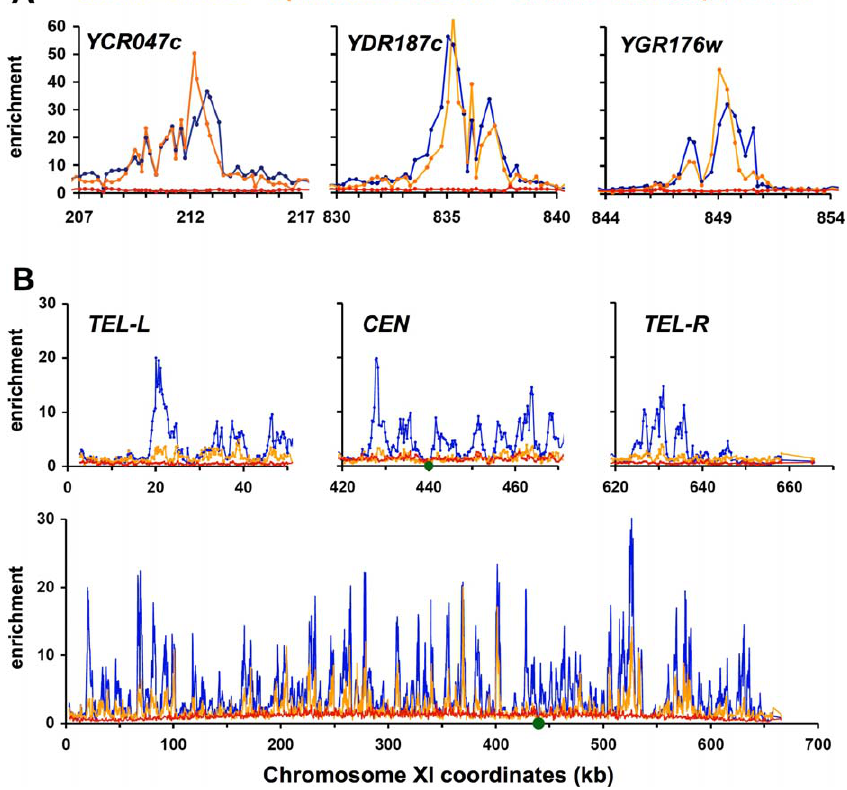
Figure 3. Examples of Concordance and Discordance between DSBs in dmc1 D and rad50S In each plot, normalized, unsmoothed array signals (average of two experiments) are as follows: orange, Spo11 ChIP from rad50S (MJL1083); blue, BND cellulose–enriched ssDNA from dmc1 D (MJL3095); red, BND cellulose–enriched ssDNA from spo11Y135F dmc1 D (MJL 3096). (A) Three concordant regions where DSB signals are similar in rad50S and dmc1 D . x -axes, chromosome coordinates (kb) on chromosomes III ( YCR047c ), IV ( YDR187c ), and VII ( YGR176w ). (B) DSB signals on chromosome XI . Insets show three discordant regions where the DSB signal in dmc1 D is much greater than in rad50S . Green dot indicates the